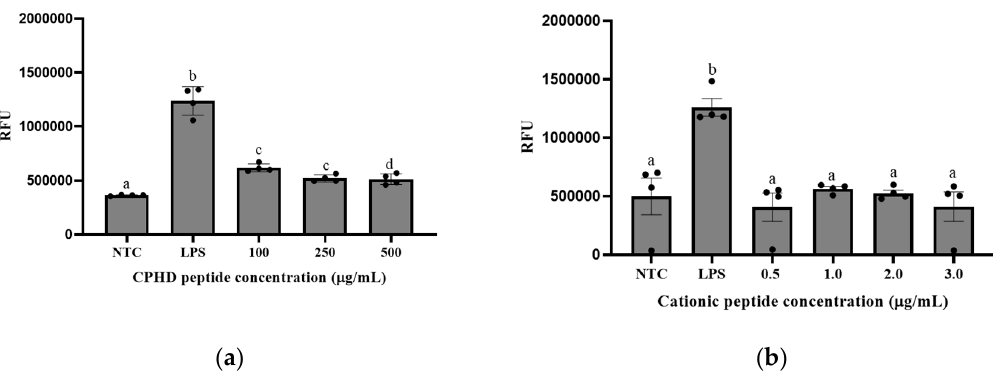
Figure 2. Peptides from ( a ) CPHD and ( b ) its cationic peptide fraction inhibits LPS-induced Figure2. Peptidesfrom( a )CPHDand( b )itscationicpeptidefractioninhibitsLPS-inducedinflammation in RAW 264.7 Cells. Di ff erent lowercase letters indicate significant di ff erences between inflammation in RAW 264.7 Cells. Different lowercase letters indicate significant differences between treatments ( p < 0.05). Samples were analyzed in quadruplicate (n = 4). Cells were stimulated for 6 h with 500 ng of lipopolysaccharide (LPS) or pre-treated with CPHD ( a ), cationic fractions, or PBS (NTC = non-treated control). The data are expressed as the Renilla luciferase activity in relative light units (RLU). Data represent the mean ± SD of quadruplicate samples, representative of four independent experiments.